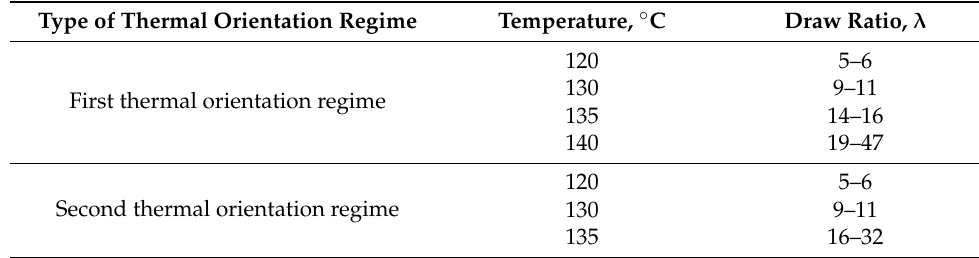
Table 1. Thermal orientation regimes and achieved values of the drawing ratio at each stage of thermal orientation process for UHMWPE composites filled with PE-wax and GNP/PANI. Type of Thermal Orientation